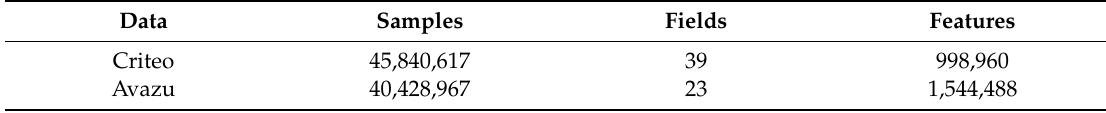
Table 1. The statistics of Criteo and